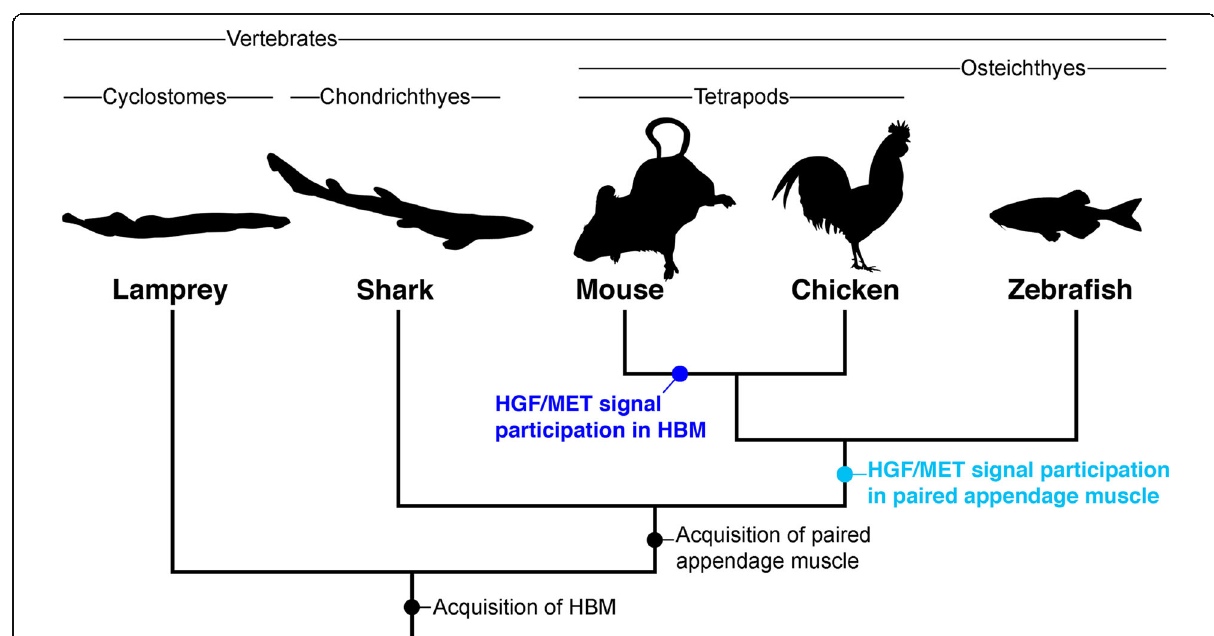
Fig. 5 Stepwise participation of HGF/MET signaling in MMP development. A vertebrate phylogeny and a hypothetical scenario of the participation of HGF/MET signaling in MMPs. A stem osteichthyan acquired Met expressions in MMPs and Hgf expressions in fin buds, and established the delamination (and possibly the migration) of fin MMPs by HGF/MET signaling. A mouse ancestor gained Hgf expressions in the migration route of HBM and evolved HGF/MET signal pathway in HBM development. HBM, hypobranchial